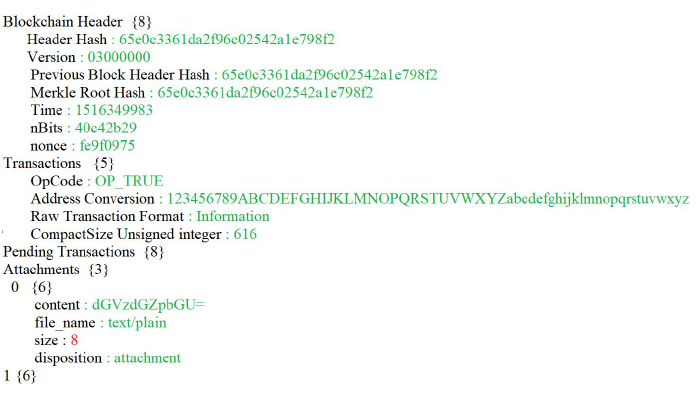
Figure 7. Evidence block in JSON script.